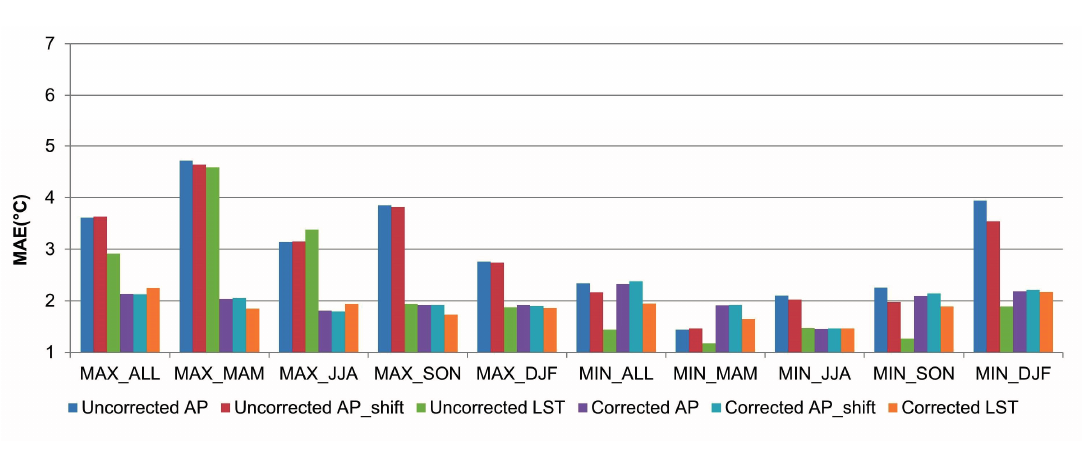
Figure 5. MAE values averaged for 60 ASOS weather stations’ locations for estimating monthly air temperature with or without the correction using the CRU data (unit: °C).